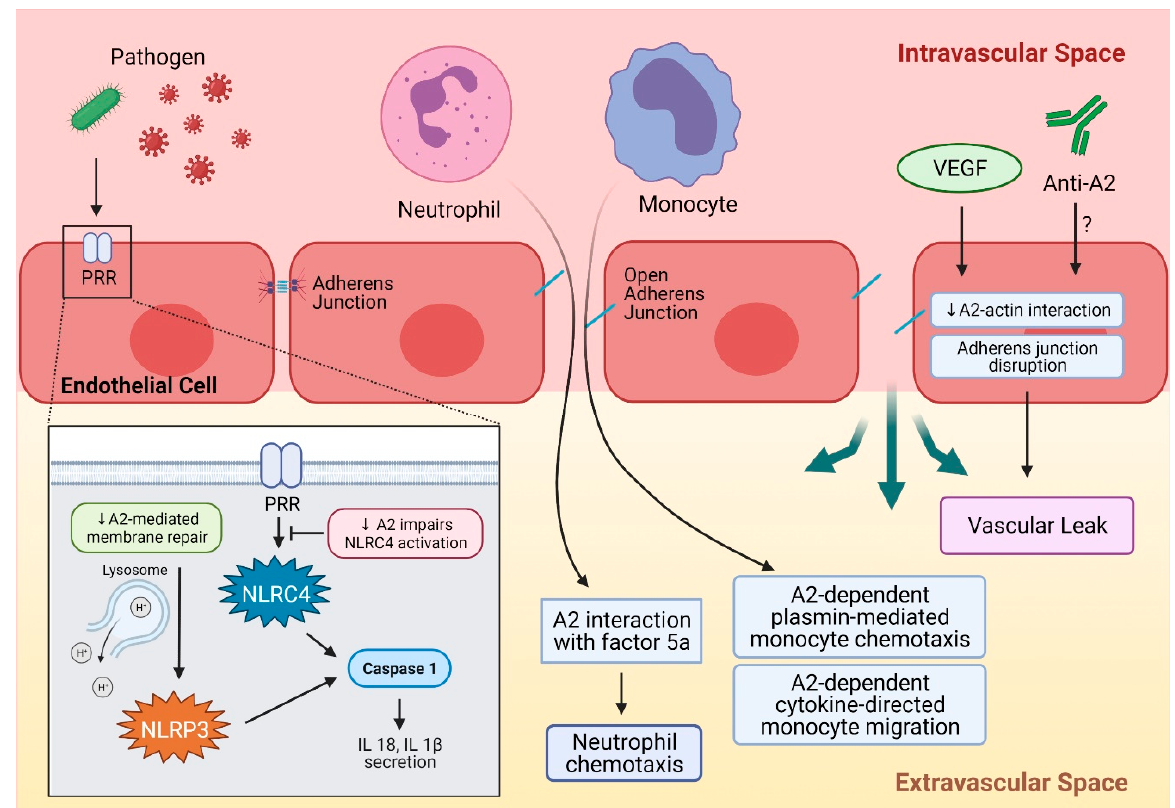
Figure 2. A summary of A2 in inflammation. Pathogens such as bacteria or viruses are recognized by PRR and activate NLRC4, which then activates caspase 1 and leads to IL-18 and IL-1 β secretion. A decrease in A2 impairs NLRC4 activation by PRR. Another inflammasome, NLRP3, can be activated by endolysosomal damage and the leakage of its contents, and results in caspase activation and pro-inflammatory cytokine secretion. A2 plays a critical role in endolysosomal membrane repair, and downregulation of A2 can impair endolysosomal membrane repair and activate the NLRP3 inflammasome. Inflammatory cells like neutrophils and monocytes can be recruited to a site of injury or insult by A2-mediated mechanisms. Neutrophil chemotaxis to the injury site occurs through A2 interaction with activated complement factor 5a. Monocytes can be recruited by A2-dependent, plasmin-mediated chemotaxis, and an A2-dependent cytokine-directed mechanism facilitates monocyte migration. A2 maintains integrity of adherence junctions through interaction with actin, and this can be interrupted by VEGF, leading to adherens junction disruption and vascular leak. A similar mechanism can be proposed for anti-A2 autoantibodies that can disrupt A2-actin interaction. A2 = annexin A2, NLRC4 = NLR family CARD-containing protein 4 inflammasome, IL-18 = interleukin-18, IL-1 β = interleukin-1 β , NLRP3 = NLR family pyrin domain containing 3 inflammasome, PRR = pattern recognition receptor, VEGF = vascular endothelial growth factor.